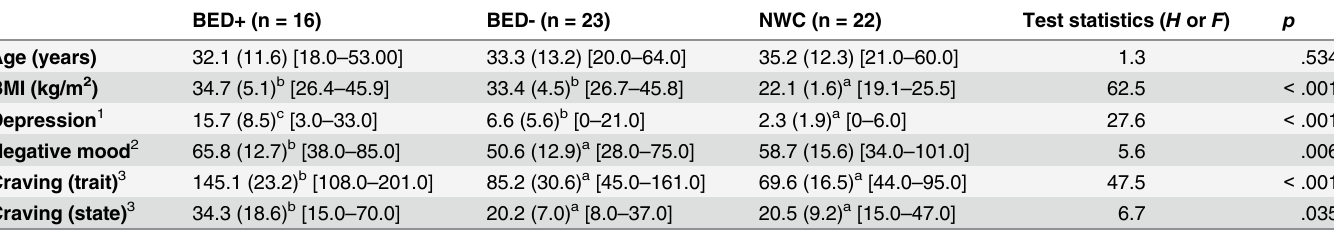
Table 1. Means (SD) [range] of sociodemographic data, psychopathology and food craving of all participants. BED+ (n = 16)